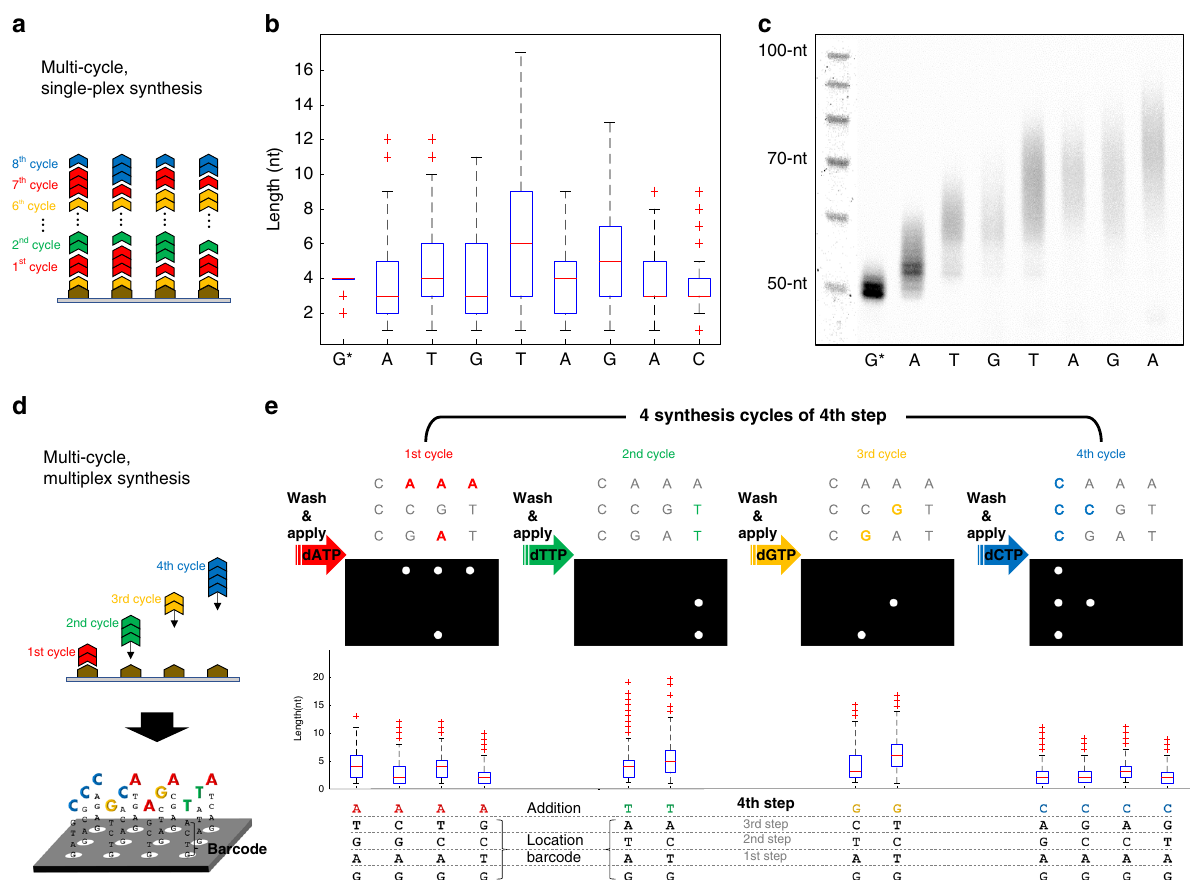
Fig. 3 Demonstration of multi-cycle and multiplex enzymatic synthesis. a An overview of multi-cycle, single-plex synthesis of a heteropolymer oligonucleotide comprised of 8 unique base transitions. Each cycle represents the addition of a single-nucleotide base type at all 12 spots on the (3 ⋅ 4) array. Synthesis results in short homopolymeric blocks of A, T, G, or C at variable lengths. b Following multi-cycle synthesis and NGS, raw sequence reads were extracted and fi ltered by the presence of the adapter sequence added by splint-end ligation after the fi nal C extension. The box-plot indicates a statistical representation of the number of extension events for each homopolymeric block for the synthesized sequence GATGTAGAC with red pluses being statistical outliers. Note that only sequencing reads that contained all eight base transitions were used to generate the box-plot and that synthesis started with a string of four G on the 3 ′ -terminus of the initiator oligonucleotide. c Denaturing gel electrophoresis analysis of each individual cycle of synthesis. Each lane represents the material retrieved of an individual fl ow cell after the appropriate number of cycles were performed. No fi nal C extension or splint-end ligation occurred for this analysis. d An overview of multi-cycle, multiplex synthesis of 12 unique heteropolymer oligonucleotides on the (3 ⋅ 4) array. Each synthesis step contained the individual cycles for the addition A, T, G, and C at the appropriate spots on the array. Sequence barcodes indicating the physical location of each oligonucleotide on the array can be built into the initiator oligonucleotide or synthesized by TdT. For each cycle, a unique mask was generated by the system ’ s DMD to locally activate TdT based on the desired sequence to be synthesized. e For example, the masks needed for the 4th step of an eight-step multiplex oligonucleotide synthesis run is shown with the appropriate post-synthesis sequencing data to verify spatially selective synthesis. Source data are provided as a Source Data fi